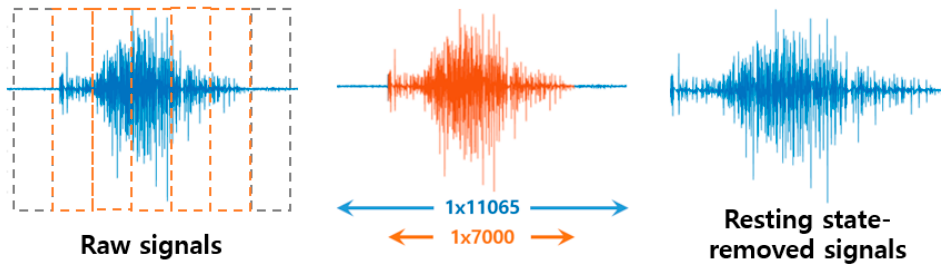
Figure 6. Removal of resting state signals.